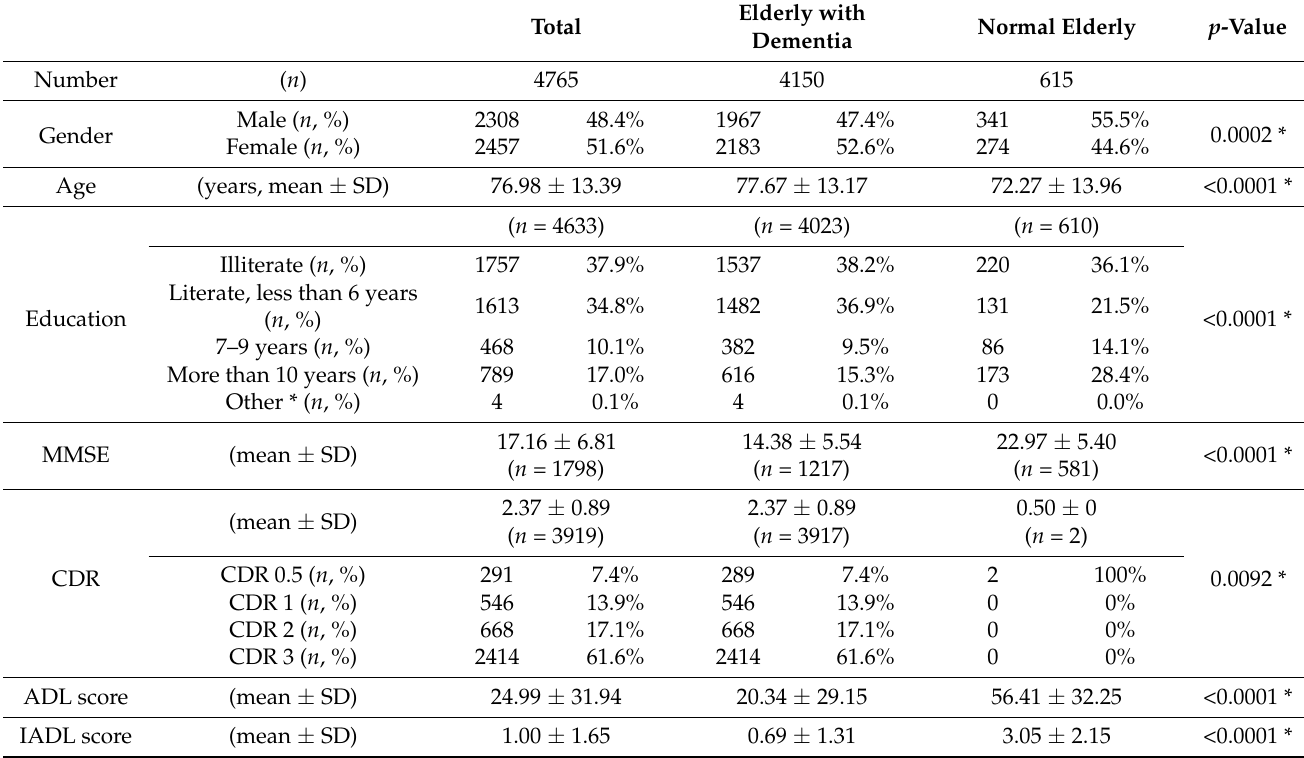
Table 3. Comparison between people with dementia and normal elderly. Elderly with Total